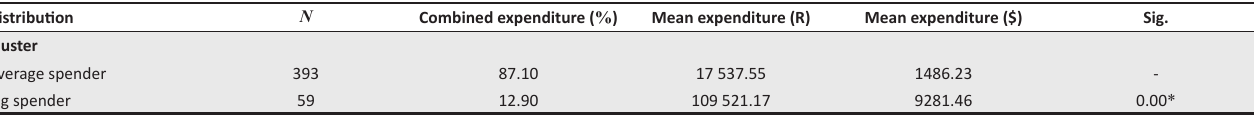
TABLE 6: Cluster distribution. Distribution N Combined expenditure ( % ) Mean expenditure (R)